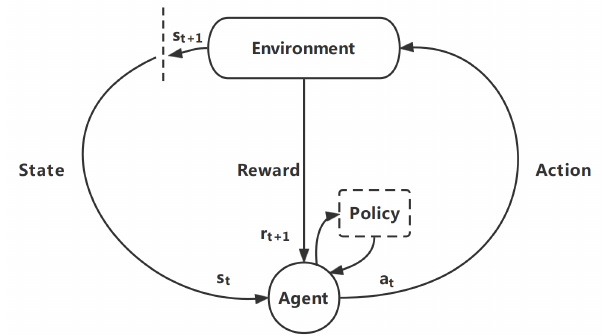
Figure 4. The agent–environment interaction in reinforcement